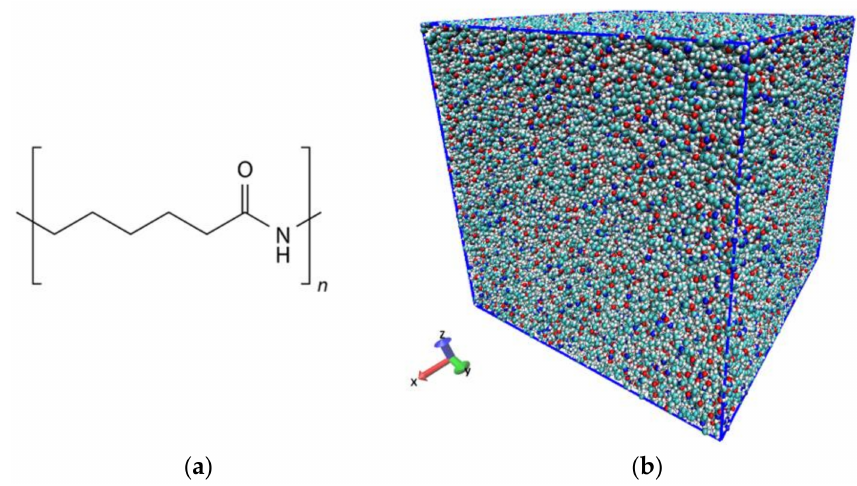
Figure 1. Illustration of ( a ) chemical structure of PA6, and ( b ) the initial system of PA6 consisting of 1000